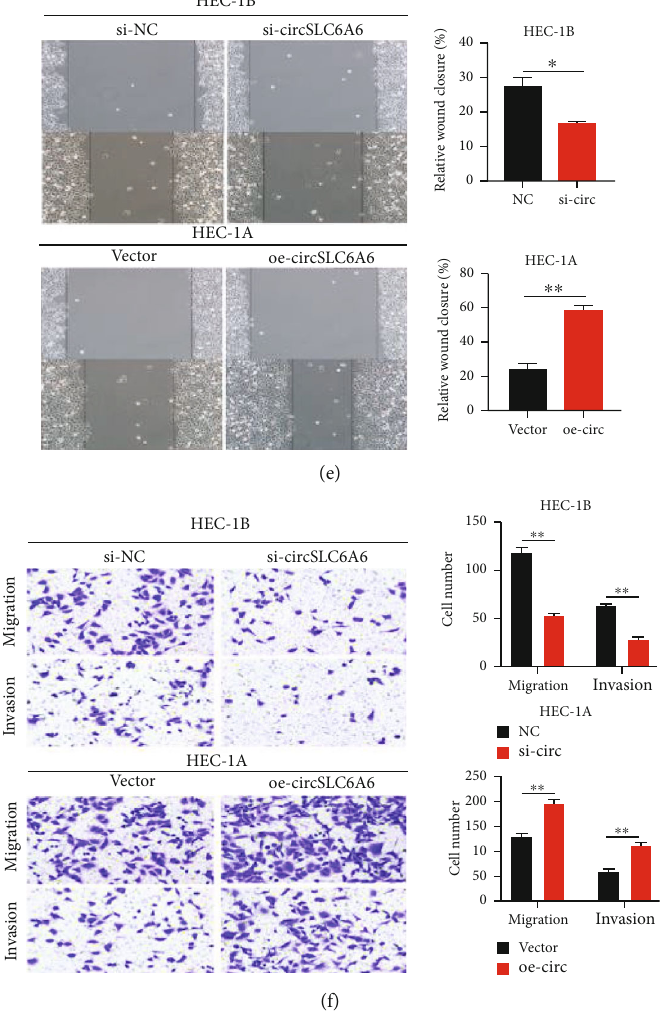
Figure 2: circSLC6A6 promotes EC cell proliferation, migration, and invasion in vitro. (a) The relative circSLC6A6 expression in HEC-1B cells transfected with si-circSLC6A6-1 and si-circSLC6A6-2, respectively, by qRT-PCR. (b) The relative circSLC6A6 expression in HEC- 1A cells transfected with oe-circSLC6A6 vectors by qRT-PCR. (c) The proliferation abilities of HEC-1B cells transfected with si- circSLC6A6 and HEC-1A cells transfected with oe-circSLC6A6 were determined by the colony formation assay. (d) The proliferation abilities of HEC-1B cells transfected with si-circSLC6A6 and HEC-1A cells transfected with oe-circSLC6A6 were determined by the EdU assay. (e) Cell migration was detected by the wound healing assay in HEC-1B cells transfected with si-circSLC6A6 and HEC-1A cells transfected with oe-circSLC6A6. (f) Cell migration and invasion abilities of HEC-1B cells transfected with si-circSLC6A6 and HEC-1A cells transfected with oe-circSLC6A6 were detected by the transwell assay ( ∗ p < 0 : 05 , ∗∗ p < 0 : 01